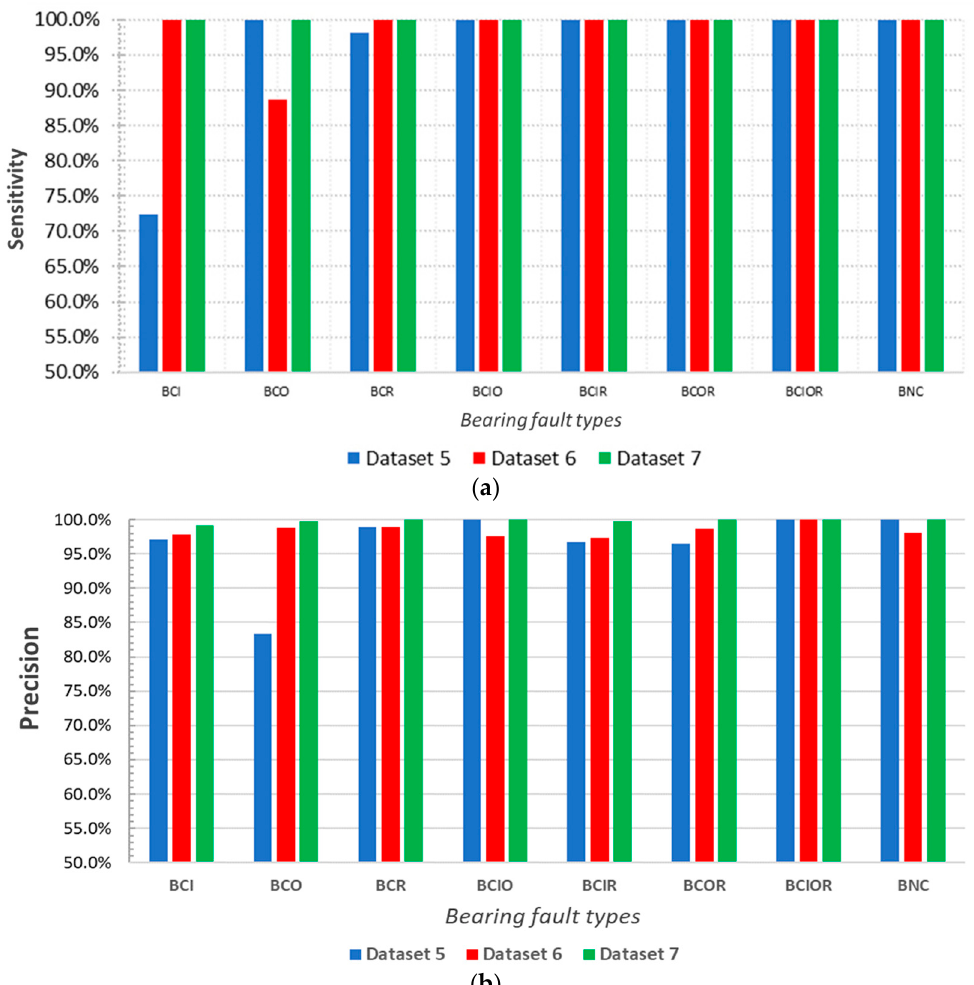
Figure8. Diagnosissensitivityandprecisionoftheproposedmethodforcompoundfaults: ( a )sensitivity Figure 8. Diagnosis sensitivity and precision of the proposed method for compound faults: ( a ) and ( b ) sensitivity and ( b ) precision.